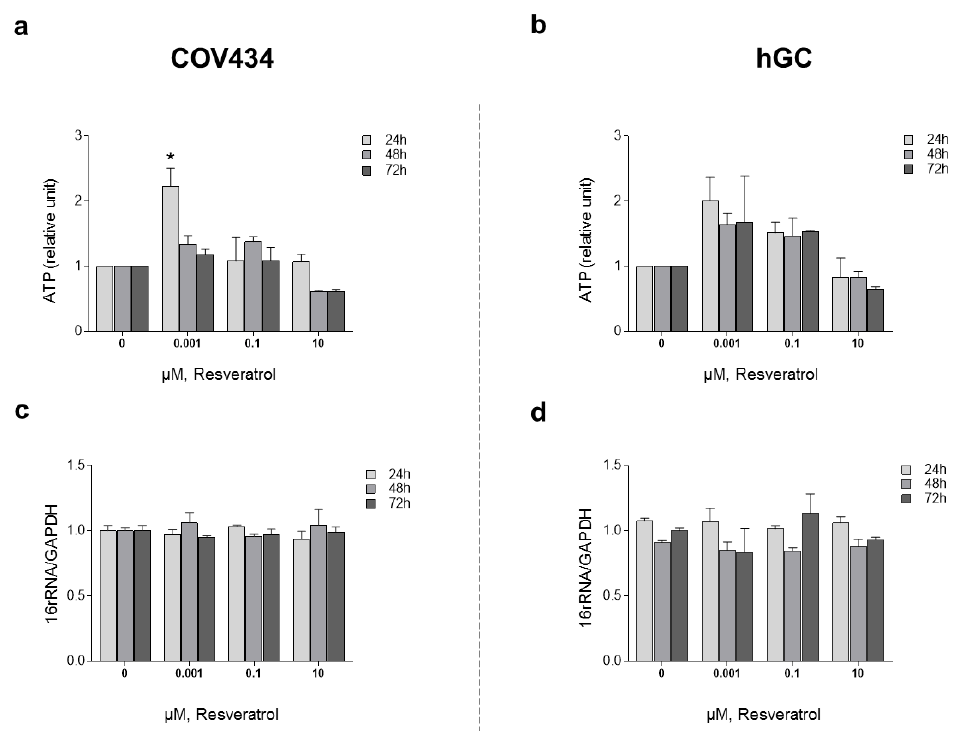
Figure 3. RES effect on mitochondrial function: ATP production. COV434 ( a ) and hGC ( b ) measurement of ATP levels after RES treatment (0.001–10 µ M) by a luminescent assay (24, 48, and 72 h). Relative mtDNA copy number was determined using quantitative real-time PCR with primers for the 16S rRNA gene (mitochondrial) and the GAPDH gene (nuclear) for COV434 ( c ) and hGC ( d ). Results were related to the control and expressed as a mean ± SEM of at least three independent experiments performed in triplicate. Significant differences between control and treated cells are indicated as * ( p < 0.05).